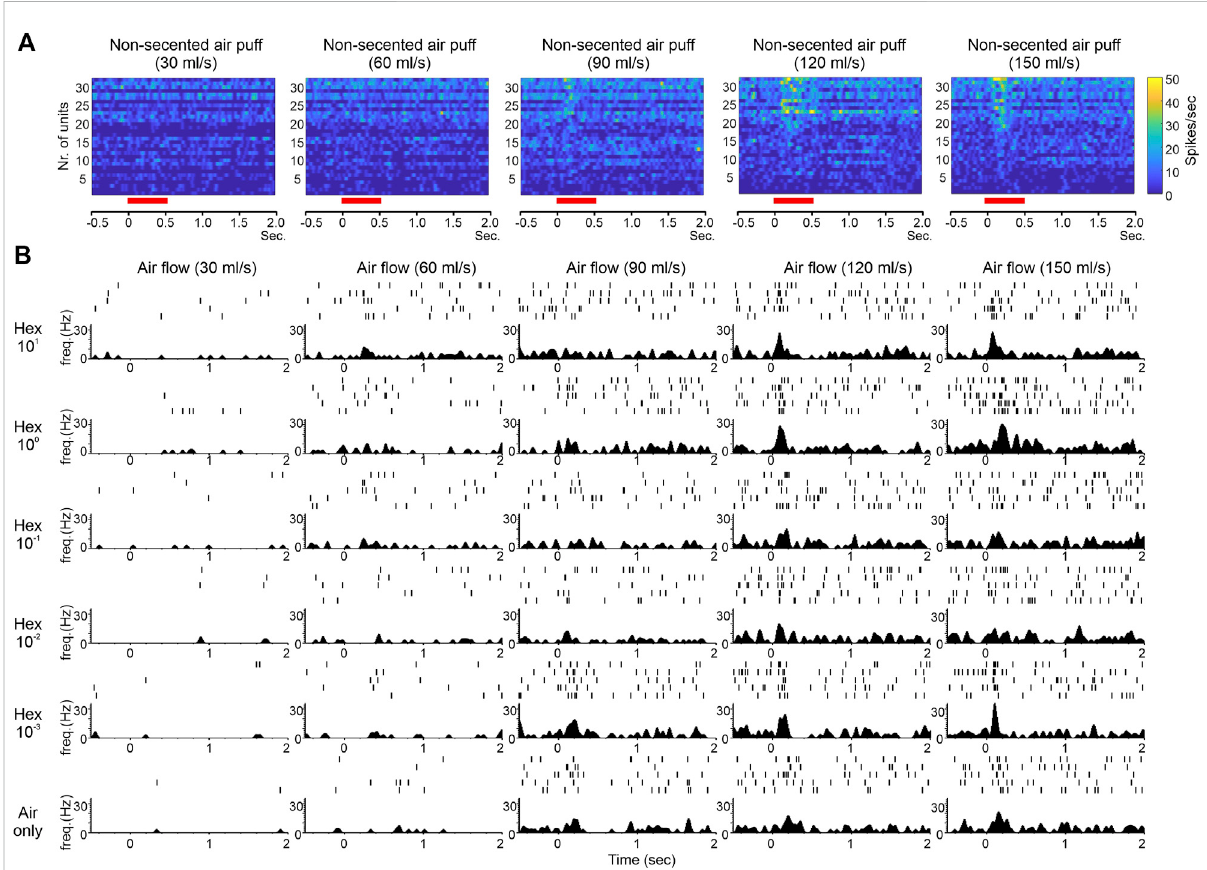
FIGURE 2 Effect of mechanical stimulation on the temporal features of odor-evoked responses. (A) Pseudo-color data matrices showing responses of 32 AL units from 4 bees to non-scented air puffs at different fl ow rate. Responses become more obvious at higher fl ow rates. Also apparent is the temporal transiency (more narrow in width) of the responses at the highest rate (150 ml/s). The red bars below the matrices indicate the duration of air puff.The histograms are Gaussian fi ltered. (B) Raster plots (rows of tick marks at the upper portion of each panel with each row representing one trial) and peristimulus time histograms (psth) (lower portion of each panel) showing the responses of one representative AL unit to 1-hexanol at fi vedifferentconcentrations (highto low from top to bottom) inconjunction of fi ve fl owrates (low to high fromleft to right). The bottom row shows responses to non-scented air puffs at different fl ow rate. Overall, the psth appears to be sharper (or more transient) at higher fl ow rates whether the response was elicited by odor or by air